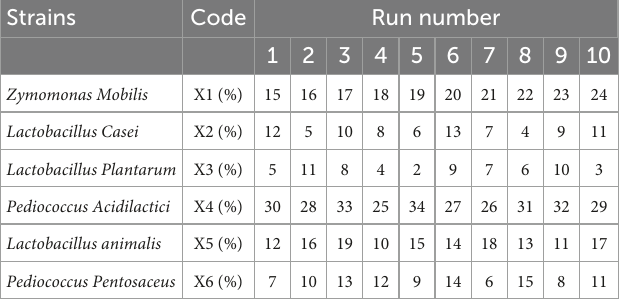
TABLE 1 Uniform design factor level table.